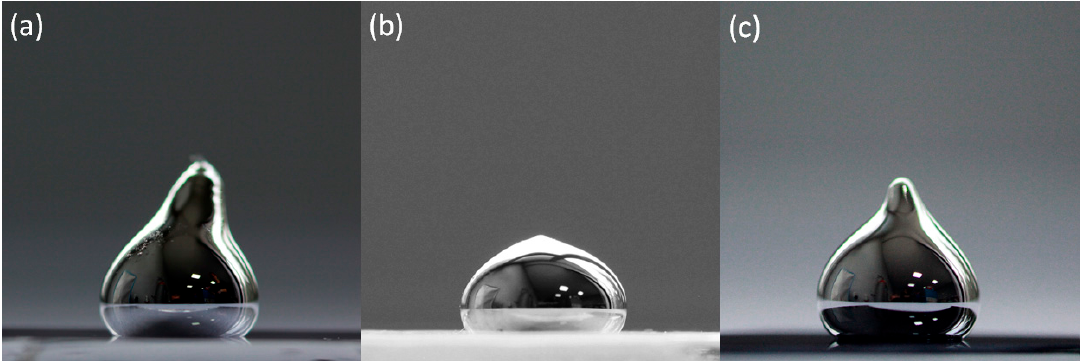
Figure 1. Representative contact angles for ( a ) glass, ( b ) quartz and ( c ) silicon.